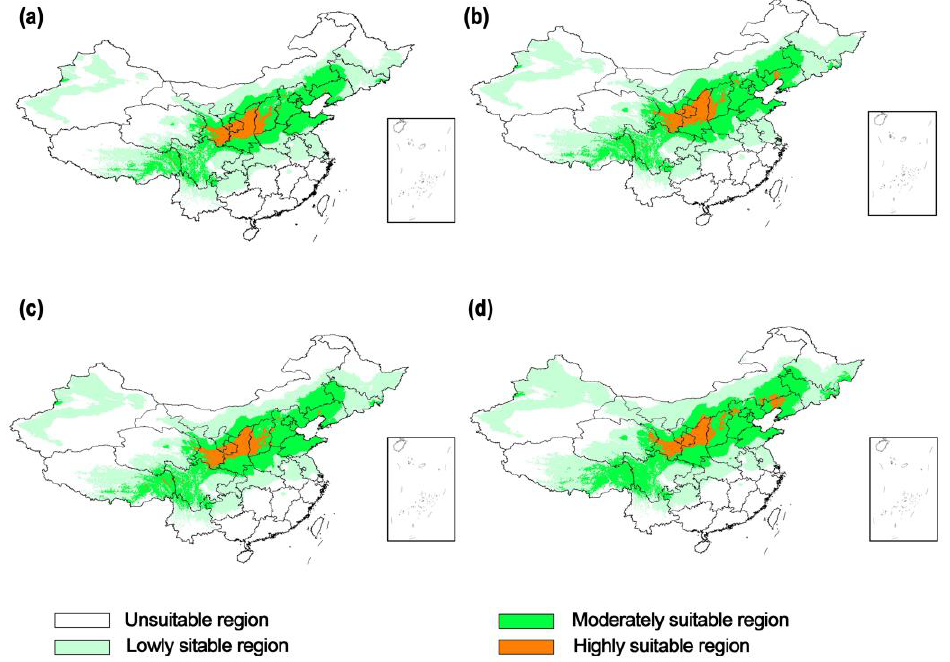
Figure 6. Potential geographical distribution of P. tomentosa under future climate change scenarios. ( a ) Representative concentration pathway (RCP) 4.5-2050s, ( b ) Representative concentration pathway (RCP) 8.5-2050s, ( c ) Representative concentration pathway (RCP) 4.5-2070s and ( d ) Representative concentration pathway (RCP) 8.5-2070s.